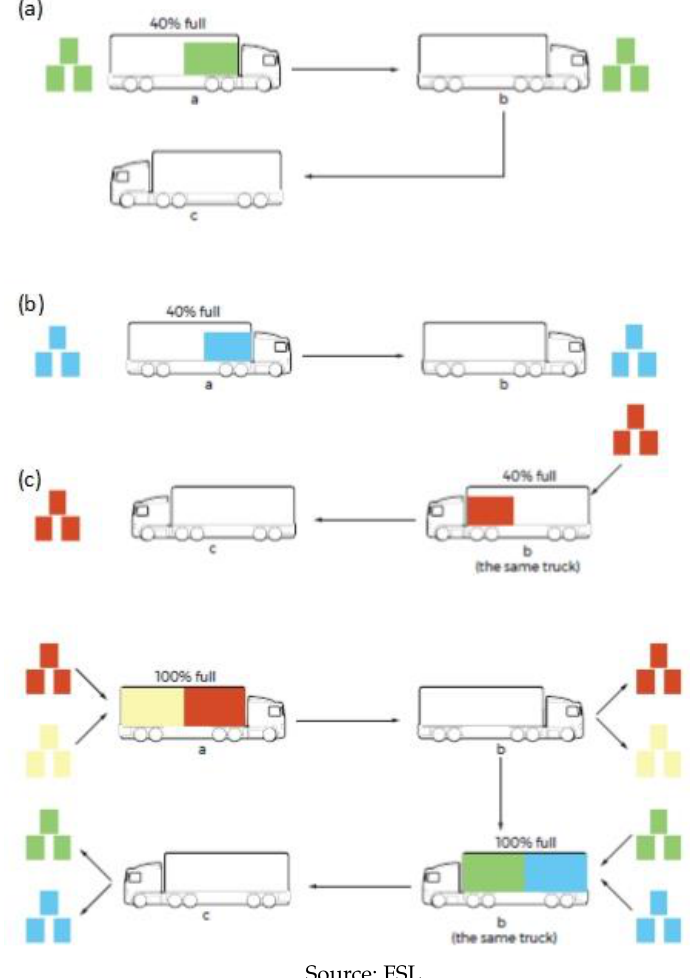
Figure 9. Concept model of FSL. ( a ) Single fleet: one vehicle, one company’s